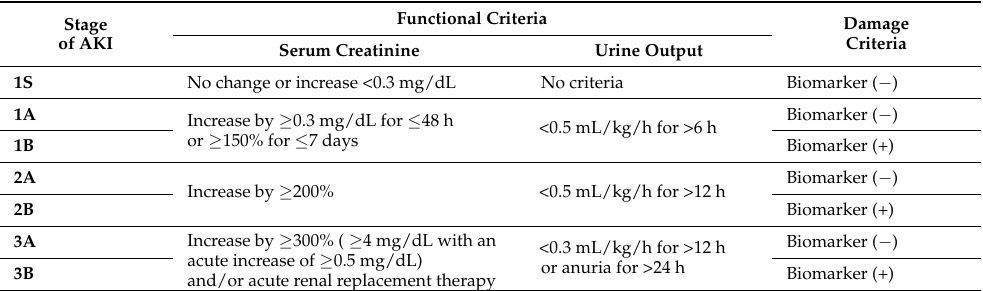
Table 1. New definition of acute kidney injury (AKI) (according to [3], modified). Functional Criteria Damage Stage CriteriaSerum of AKI